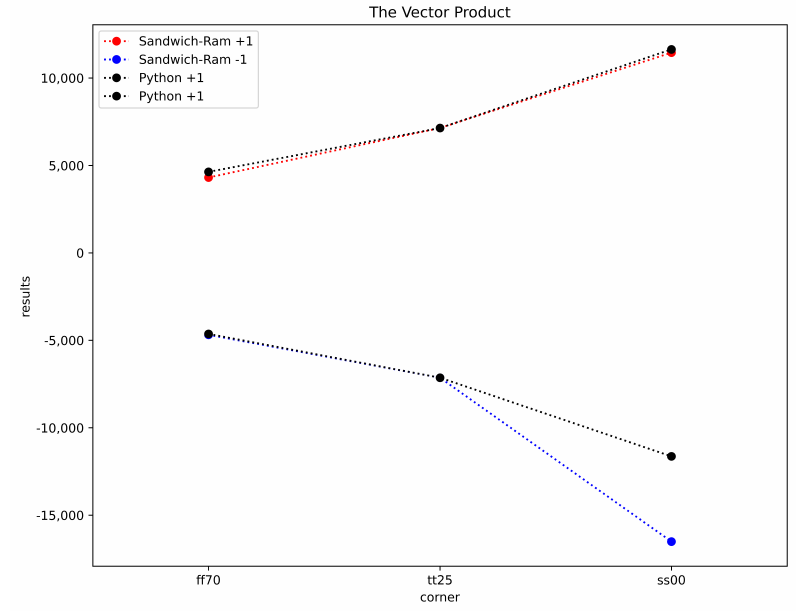
Figure 3. Verification of pulse-width deviation